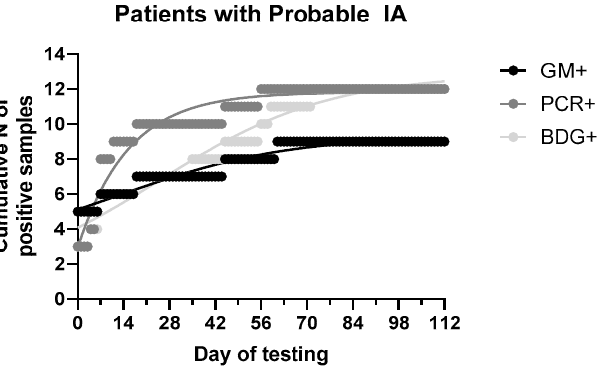
Figure 4. Cumulative distribution of fungal biomarkers [galactomannan (GM), 1,3- β -D glucan (BDG) and Aspergillus DNA (PCR)] in patients with probable invasive aspergillosis (IA).